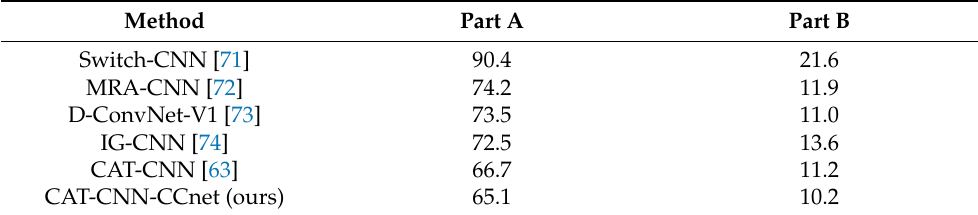
Table 1. Visual Counting subsystem: performance benchmark (metric: MAE).